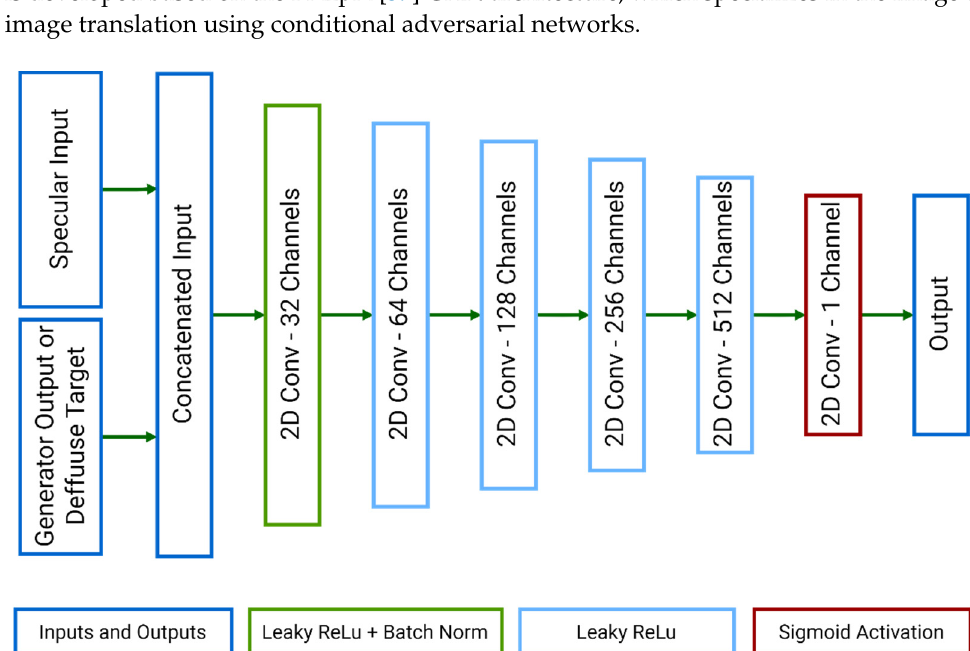
Figure 14. The generator network architecture used in SpecToPoseNet . Batch normalization is also used in almost all the layers in the generator, which can help stabilize and accelerate the learning process [39]. As seen in Figure 14, the first layer does not use batch normalization as by doing so, the colors of the input image can become